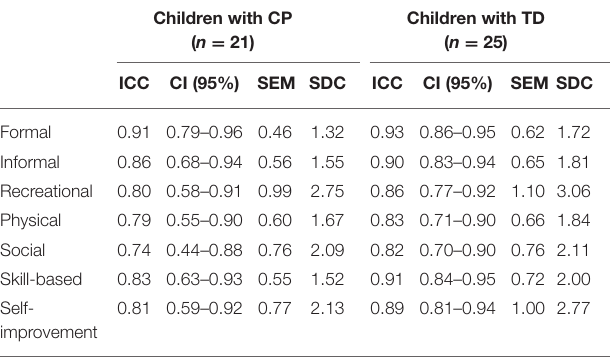
TABLE 5 | Test-retest reliability of CAPE frequency